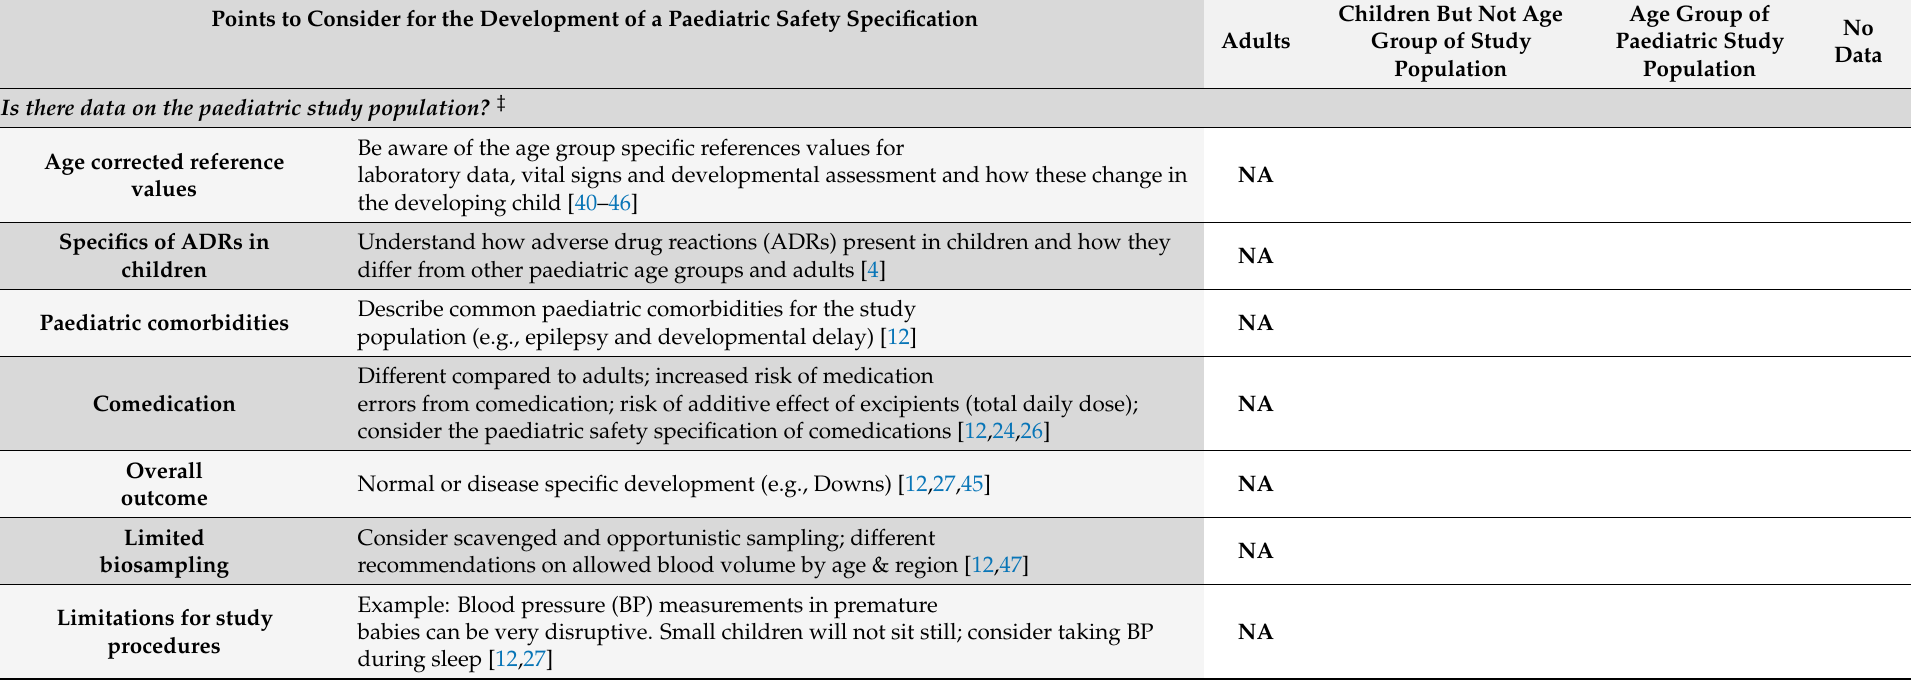
Data Available for